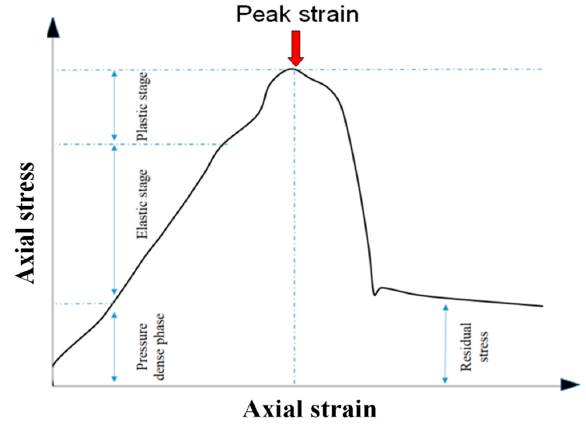
Figure 13. Whole stress–strain process curve.